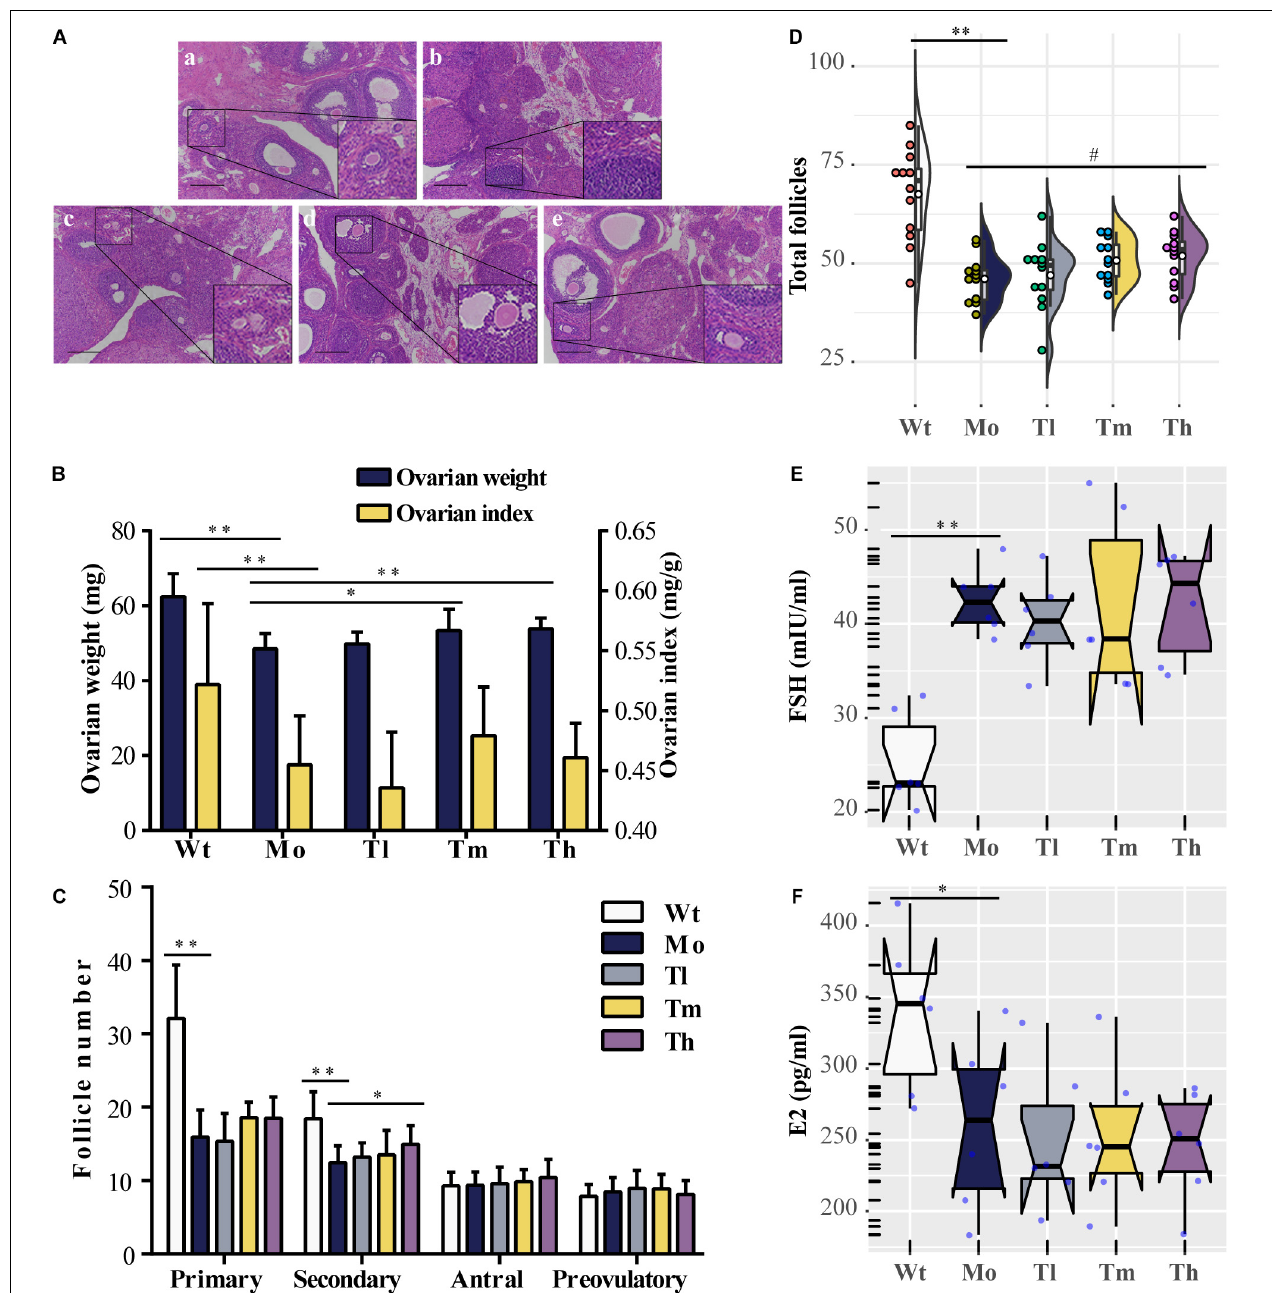
FIGURE 1 | Effects of rhGH on ovarian function during POI treatment. (A) Hematoxylin-eosin staining for the ovarian tissues ( a, b, c, d, and e for the Wt, Mo, Tl, Tm, and Th groups, respectively. n = 12, scale bar = 200 µ m, × 100 magnification). (B) Ovarian weight (midnight-blue part) and ovarian index (yellow part) for each group ( n = 12, ∗ P < 0.05, ∗∗ P < 0.01). (C) Different follicles including primary, secondary, antral, and preovulatory follicles counted after treatment ( n = 12, ∗ P < 0.05, ∗∗ P < 0.01). (D) Half violin plot showed the total follicles from ovary enumeration ( n = 12, # P = 0.08, ∗∗ P < 0.01). Each dot represented a sample. (E,F) Notched boxplots recorded the concentrations of FSH and E 2 in rat serum of the five groups, detected using ELISA kits. The nested scatter plot as well as the rug plot in the y-axis represented each sample ( n = 6).